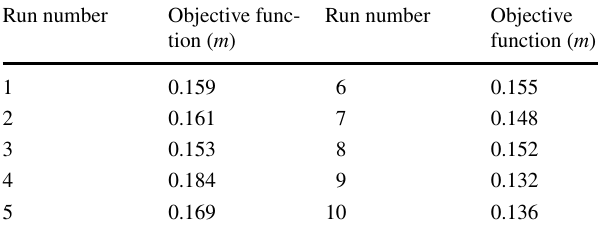
Table 3 The achieved results from